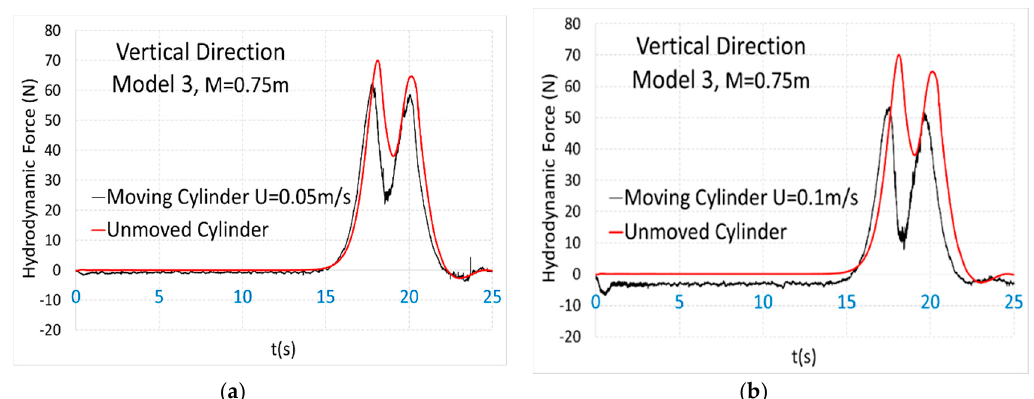
Figure 21. The time variation of hydrodynamic forces for model 3. ( a ) The comparison between the unmoved cylinder (red line) and the moving cylinder at U c = 0.05 m/s. ( b ) The comparison between the unmoved cylinder (red line) and the moving cylinder at U c = 0.1 m/s.